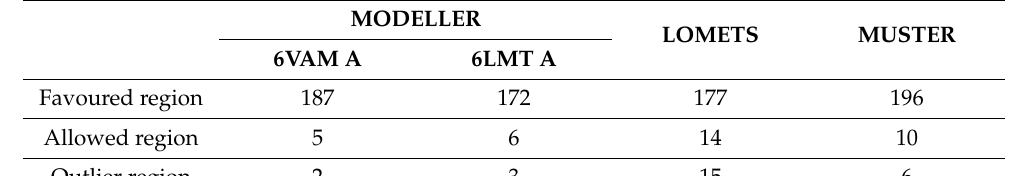
Figure 9. Ramachandran plots for ( a ) MODELLER ( 6VAM A ); ( b ) MODELLER ( 6LMT A ); ( c ) LO-ETS server; ( d ) MUSTER server.